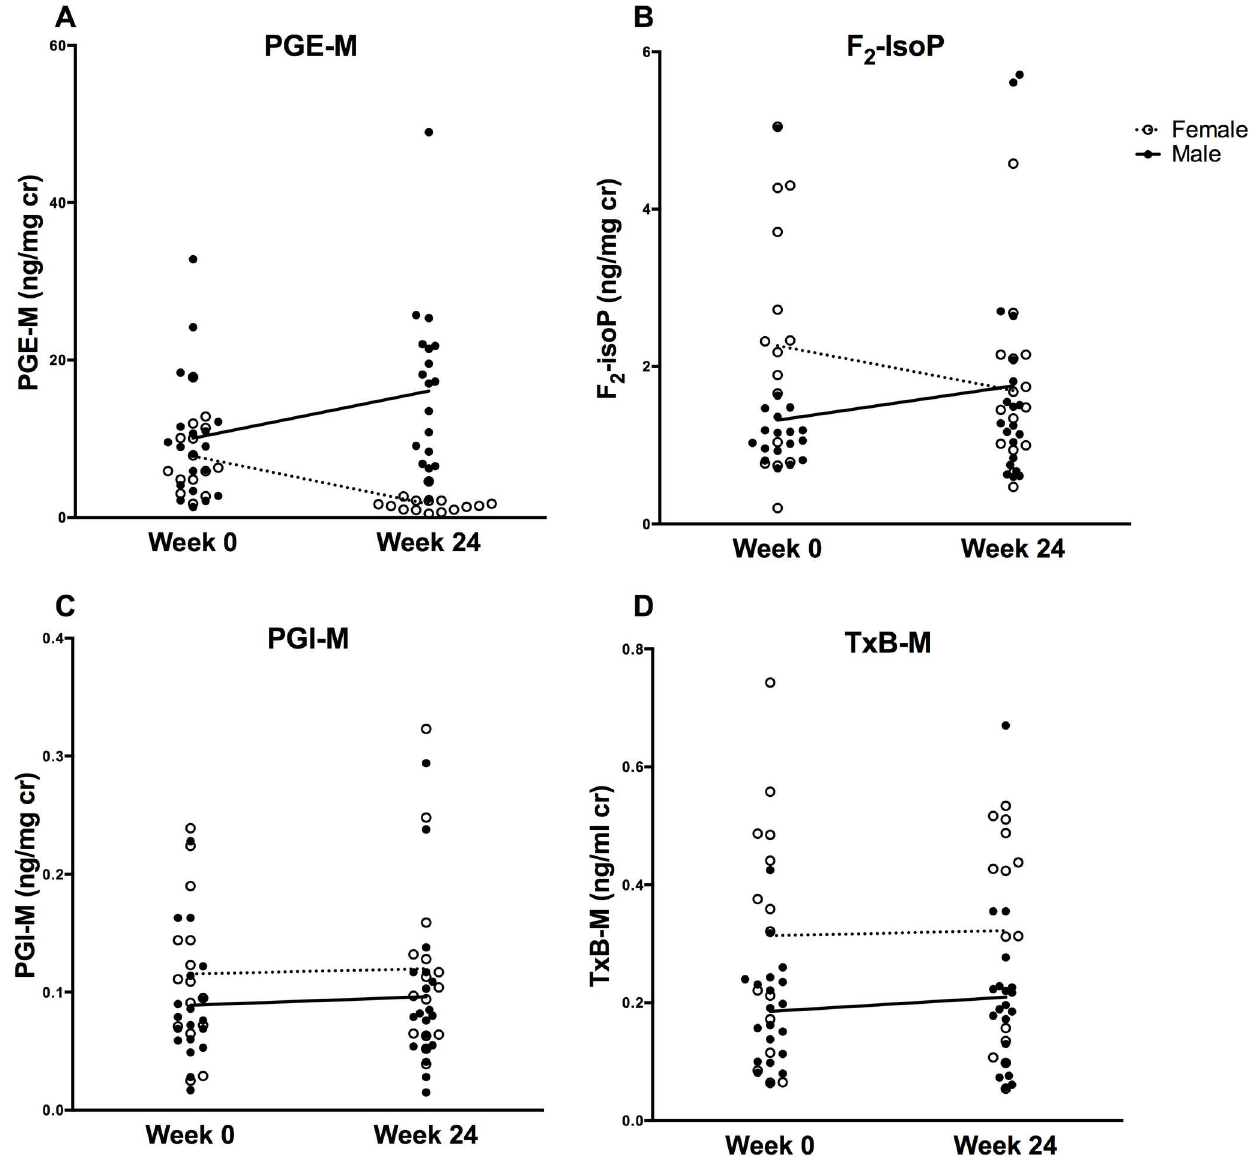
Fig 1. Urine eicosanoid levels at baseline and 24 weeks of telmisartan. Panel A: Scatter plot of baselineand 24-weekurine PGE-M levels (ng/mg cr). Solid lines representmedian changein male participants, dotted lines represent medianchangesin females. Mann-Whitney U p = 0.03 (males) and p = 0.12 (females). Panel B: Scatter plot of baselineand 24-weekurine F 2 -IsoP levels (ng/mg cr). Mann-Whitney U p = 0.06 for males, p = 0.19 for females. Panel C: Scatter plot of baselineand 24-weekurine PGI-M levels (ng/mg cr). Mann-Whitney U p = 0.71 for males, p = 0.76 for females. Panel D: Scatter plot of baselineand 24-weekurine TxB-M levels (ng/mg cr). Mann-Whitney U p = 0.84 for males, p = 0.95 for